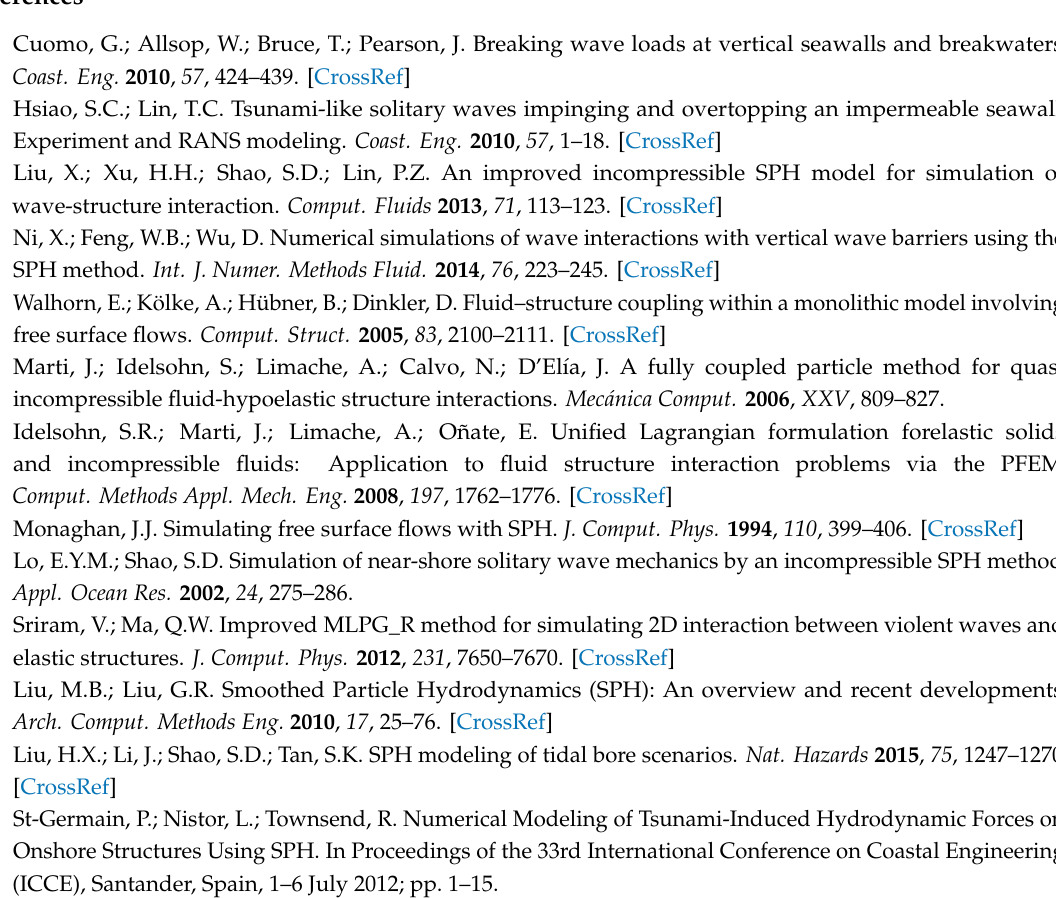
Figure A2. Comparisons between numerical and experimental results of water surface elevations at different locations: ( a ) H1; ( b ) H2; ( c ) H3; ( d ) H4.